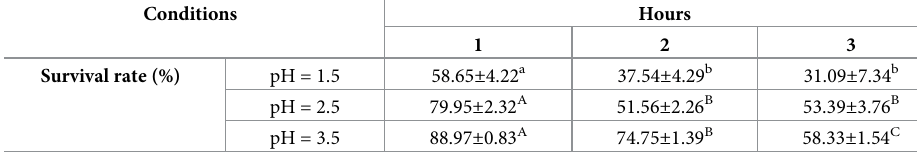
Table 5. Survival rate of C . sartagoforme XN-T4 in artificial gastric